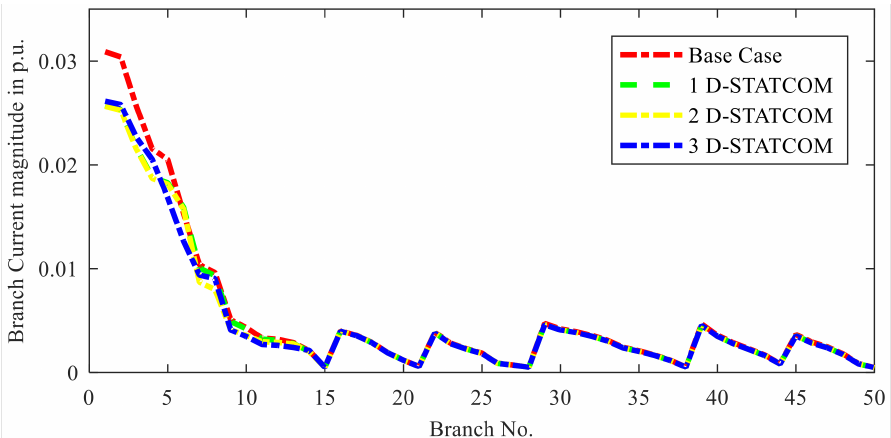
Figure 17. Comparison of current profile with and without D-STATCOMs of 33-bus PDN.